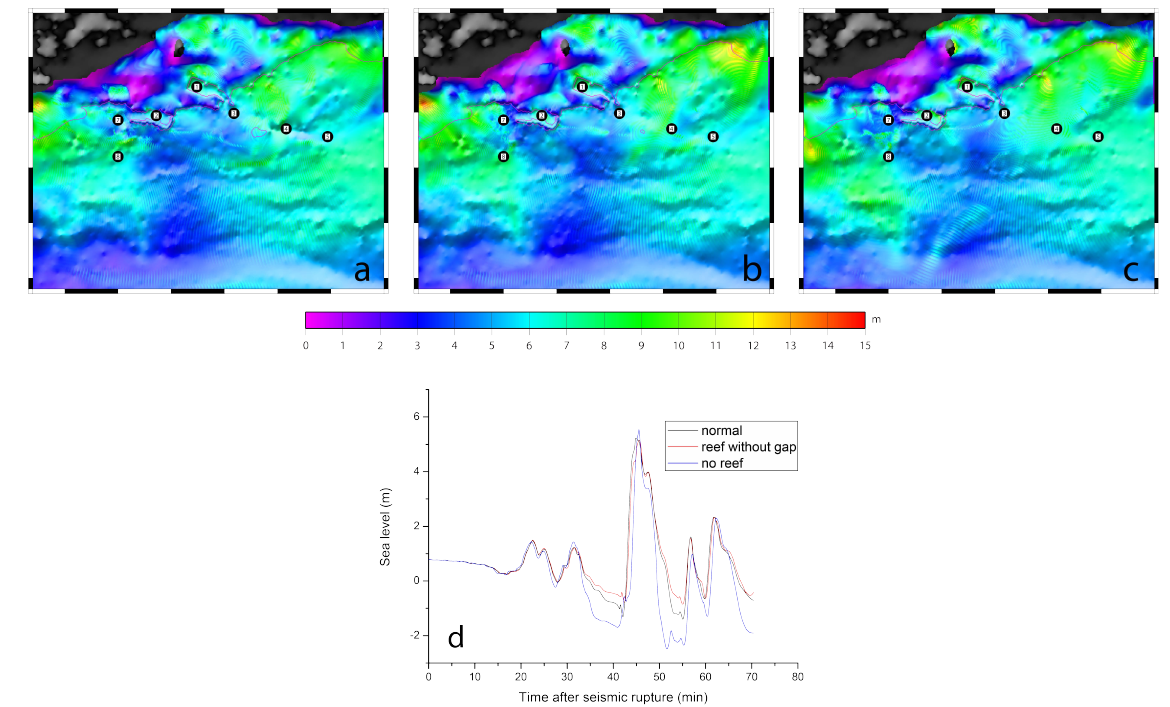
Fig. 11. Maximum water depths illuminated by a bathymetric gradient and inundation limit obtained on 3 different cases of Grid 4 (Saint- Franc¸ois) after one hour of tsunami propagation: (a) normal case; (b) reef without gap in front of the Marina; (c) no reef in front of the Marina. (d) Presents the synthetic tide gage records at the Marina entrance in the 3